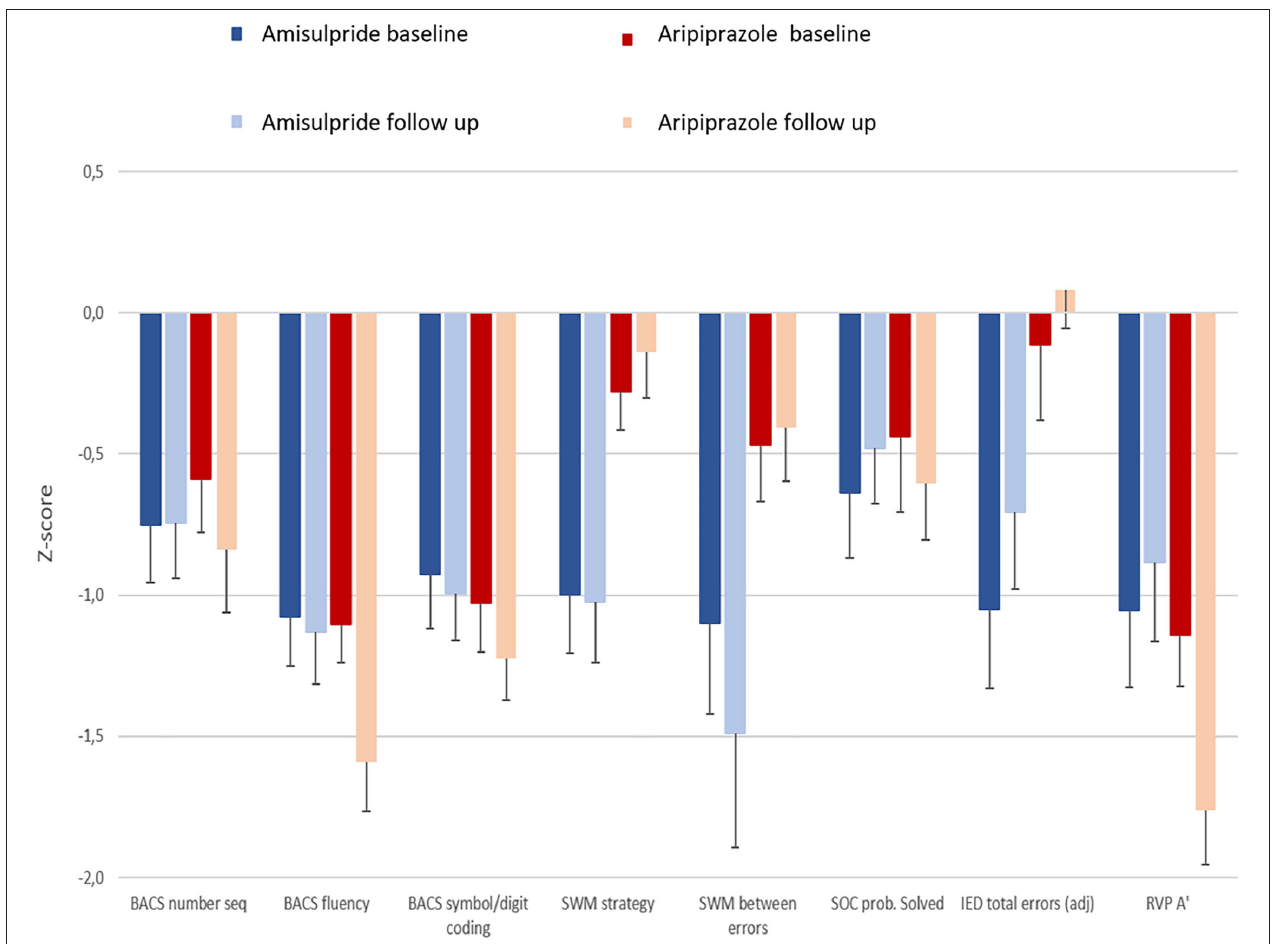
FIGURE 3 | Bar graph illustrating cognitive performance for patients in both cohorts at baseline and after 6 weeks as measured by z -score.